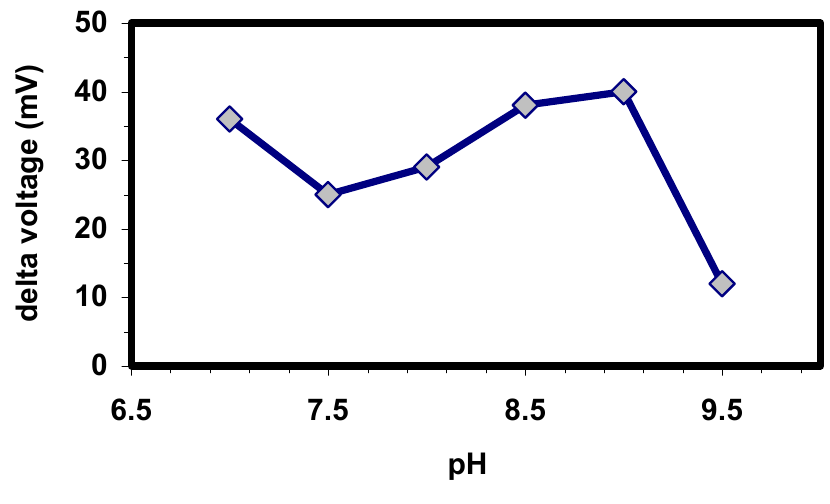
Figure 4. Effect of pH of the HEPES buffer (0.2 mM) on the signal amplitude of the EIS biosensor at 50 µM